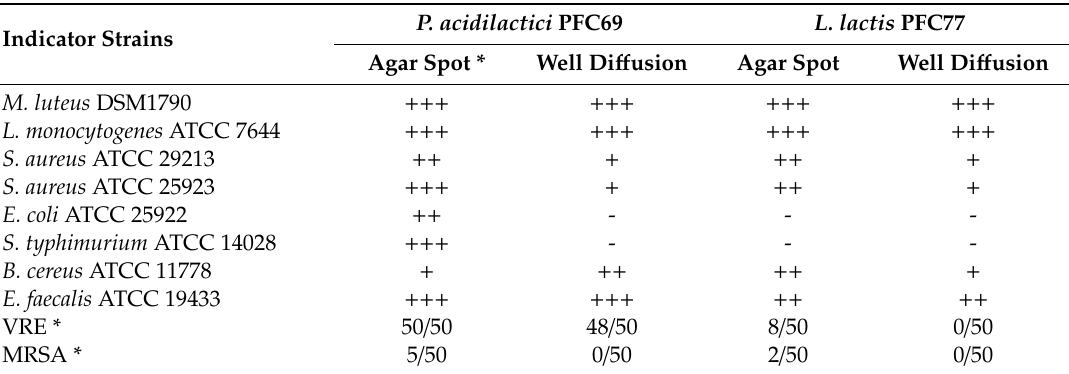
Table 1. The antimicrobial spectrum of P. acidilactici PFC69 and L. lactis PFC77. P. acidilactici PFC69 Indicator Strains Agar Spot * Well Di ff usion Agar